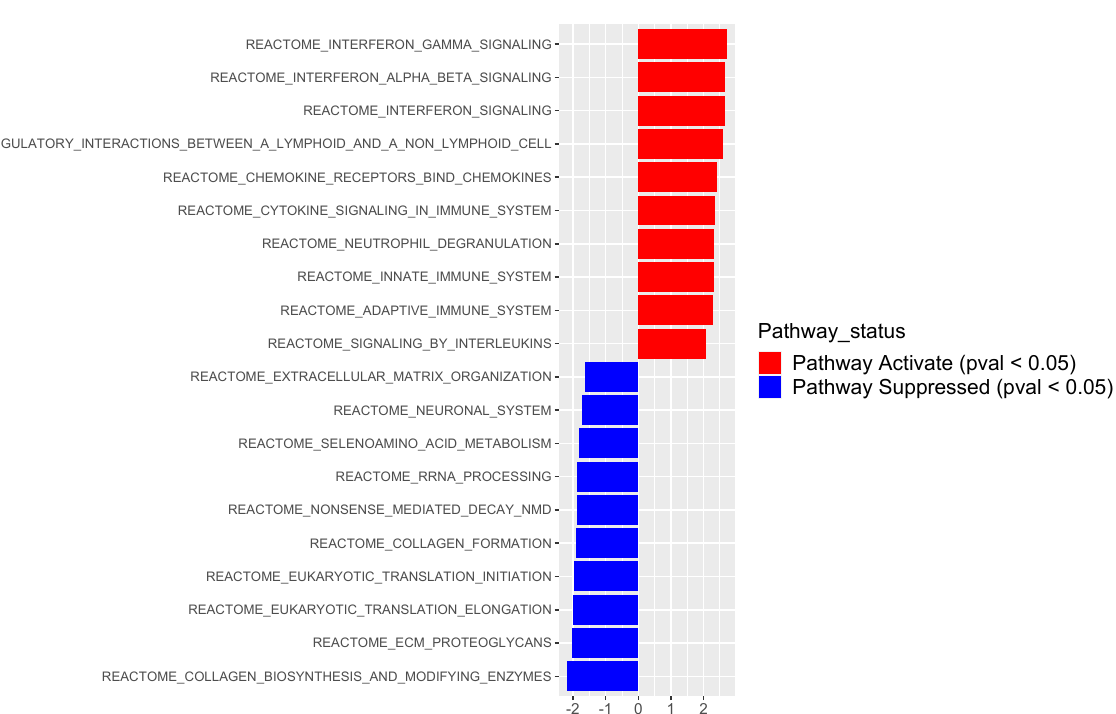
Figure 3. Normalized enrichment scores (NES) of top 10 most activated and top10 most suppressed pathways comparing High versus Low PSMB9 expression level. Red color indicates activation, while blue color indicates suppression. Reactome gene set from MSigDB curated gene set (C2) was used as input. Pathways related to the immune system and inflammatory response were significantly activated, while pathways related to the extracellular matrix were suppressed.